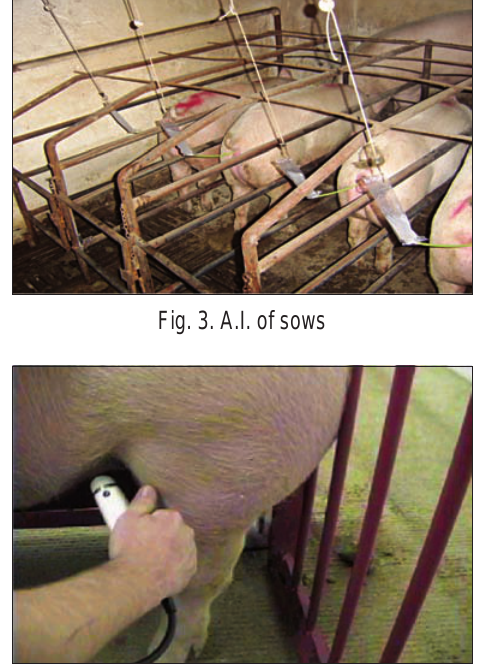
Fig. 4. Pregnancy